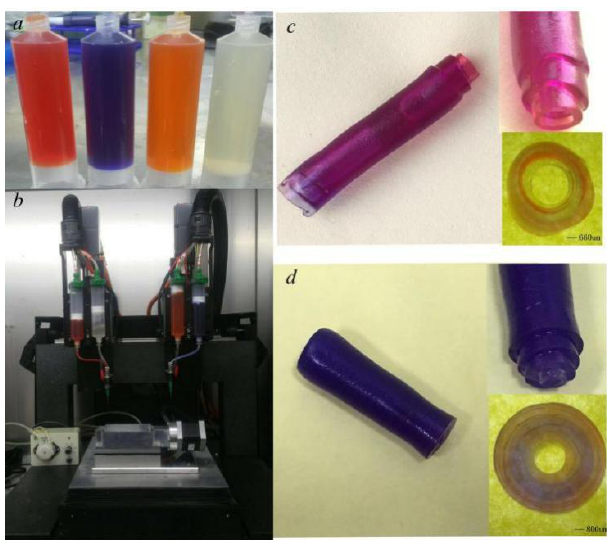
Figure 10. Vessel-like structure printing experiment: ( a ) materials, ( b ) 3D bioprinter, ( c ) vessel-like structure with three layers, and ( d ) vessel-like structure with four layers.